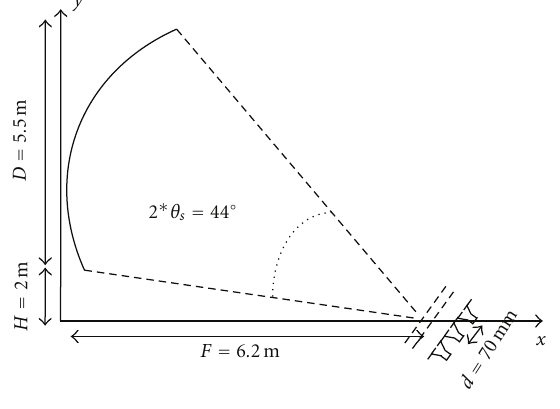
Figure 23: Reflector antenna